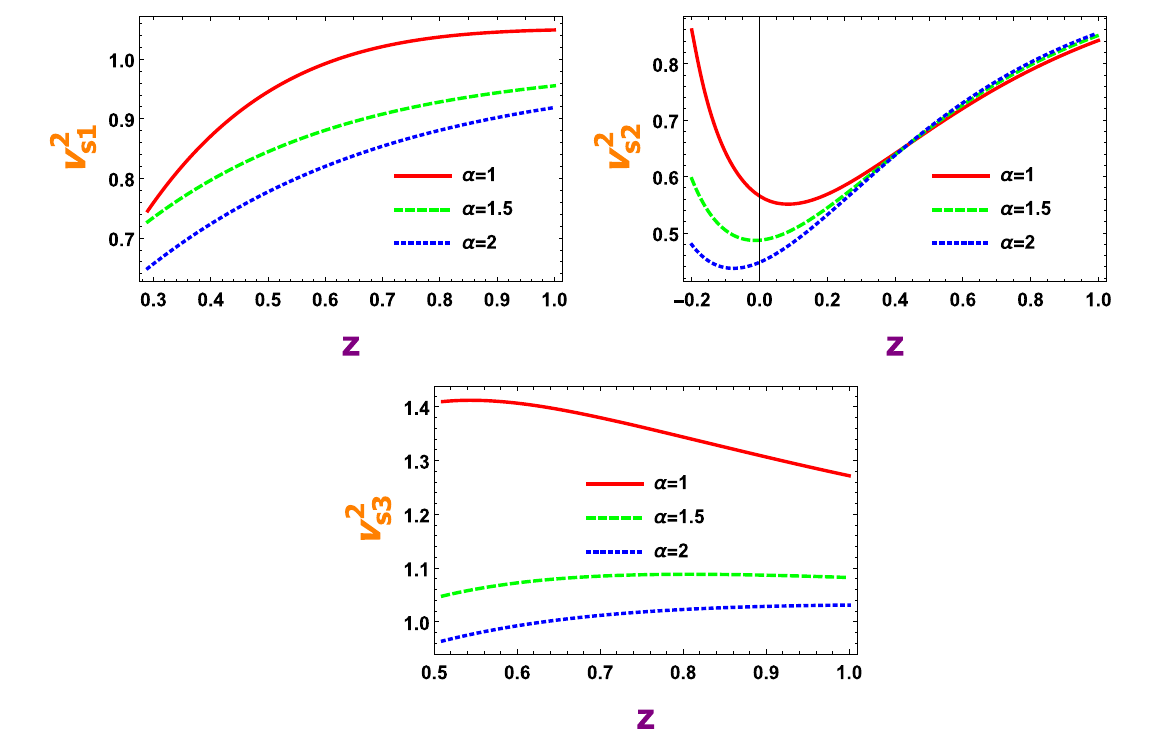
Fig. 5 The plot of square speed of sound v 2